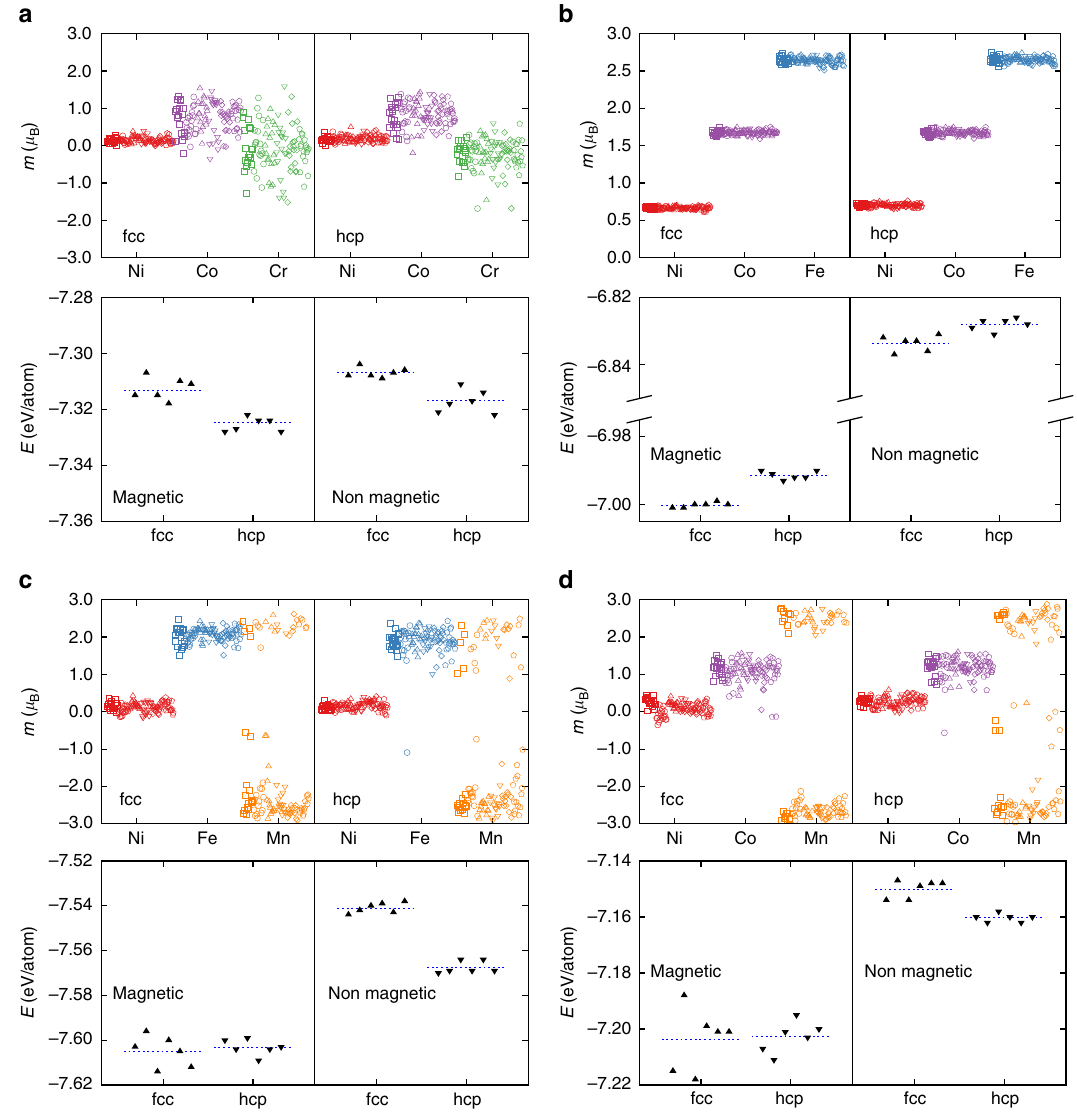
Fig. 4 Magnetic effect on hcp-fcc energies in equiatomic ternary derivatives of CrMnFeCoNi. a corresponds to CrCoNi which is repeated from Fig. 3 for comparison. Panels b , c and d correspond to FeCoNi, MnFeNi and MnCoNi respectively. In each panel the fi rst row shows the atomic magnetic moments and the second row compares the fcc and hcp energies of 6 con fi gurations of each alloy, computed with DFT with and without considering magnetism. As evident in c , d only alloys containing Mn have similar energies in both fcc and hcp phases accompanied by signi fi cant frustration of Mn magnetic